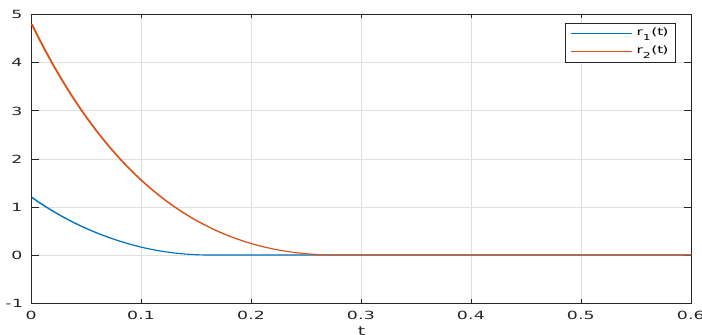
Figure 4. The synchronization error system with the